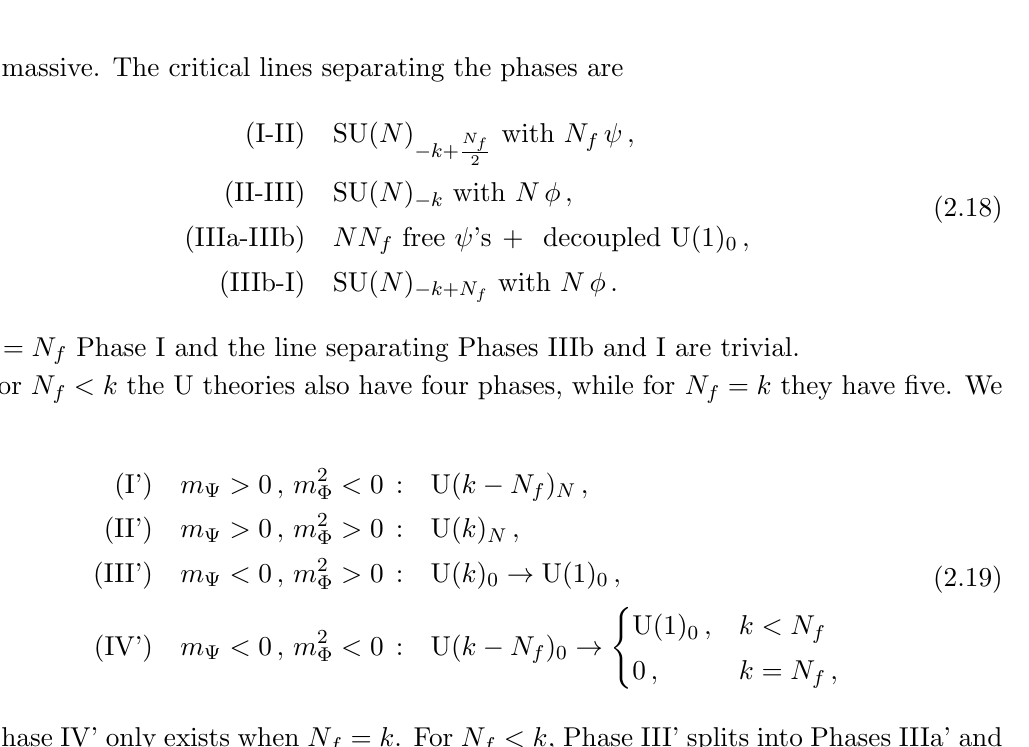
Figure 2. For N s = N and k < N f , the schematic phase diagrams of (a) SU( N ) Simons theory coupled to N f fermions and N s scalars and (b) U( k ) coupled to N s fermions and N f scalars. The various phases are described by (2.17) and (2.19). and the critical lines are described by the CFTs given in (2.18) and (2.20). The shaded region is